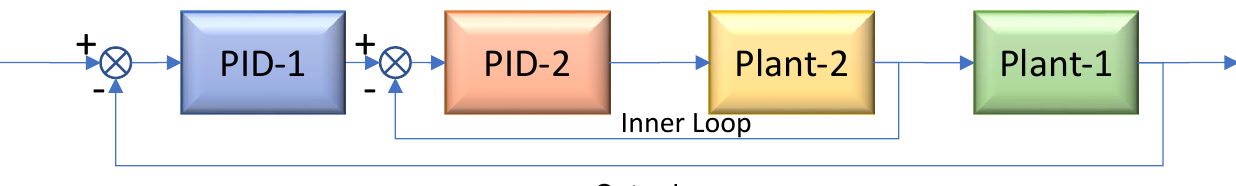
Figure 4 . CC-PID schematic. Figure 4. CC-PID